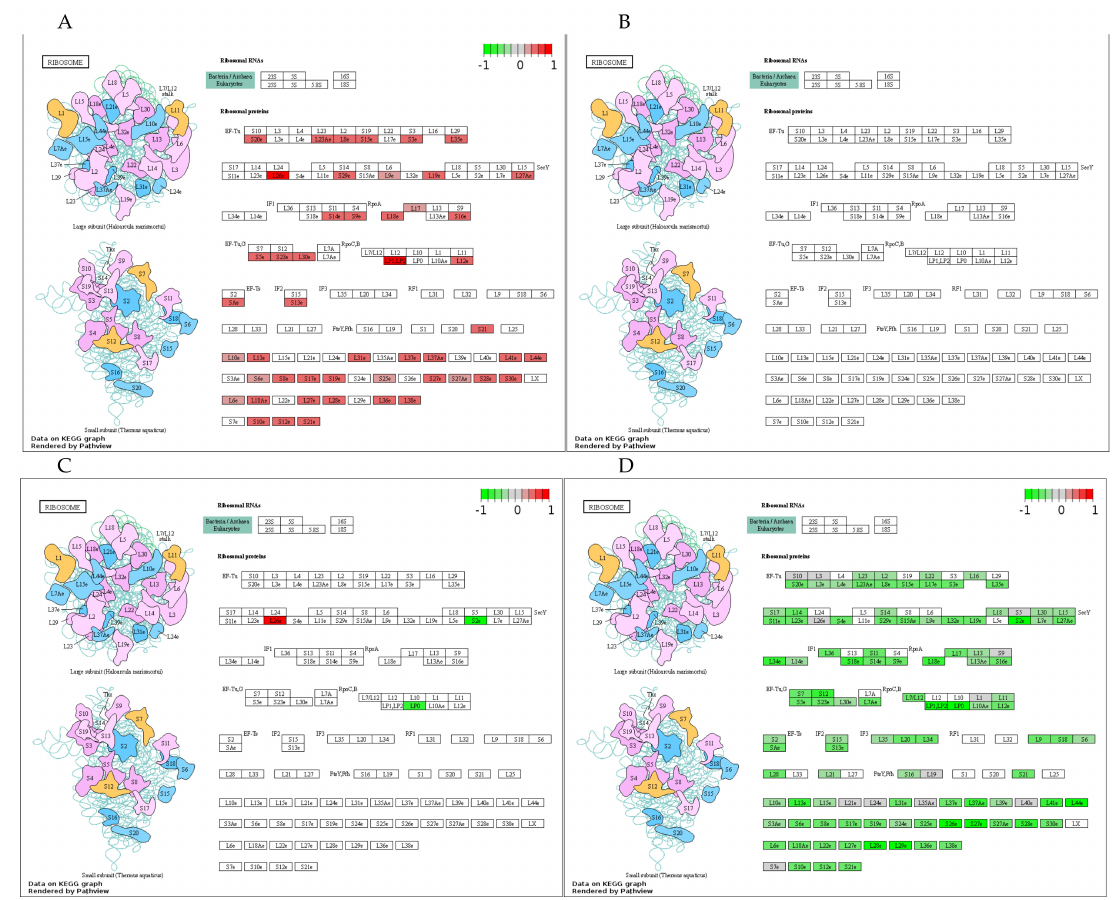
Figure 5. Regulation of ribosome expression in the pituitary gland and the influence of training. KEGG (Kyoto Encyclopedia of Genes and Genomes) pathway analyses of DEGs (FDR ≤ 0.05) in all comparison groups (( A ): DUC tr. vs. sed.; ( B ): DUhTP tr. vs. sed.; ( C ): DUhTP sed. vs. DUC sed.; ( D ): DUhTP tr. vs. DUC tr.) via https://pathview.uncc.edu (access date: 08/03/2021). Abbreviation: sed. = sedentary, tr. = trained, vs. =